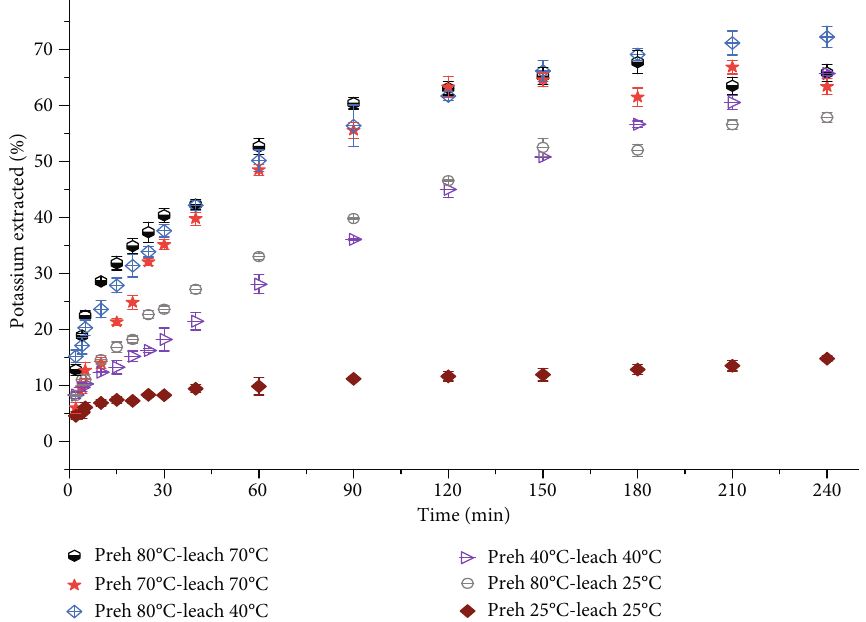
Figure 3: Leaching curves for potato spheres of di ff erent pretreatments leached at 25, 40, and 70 ° C for 4h.